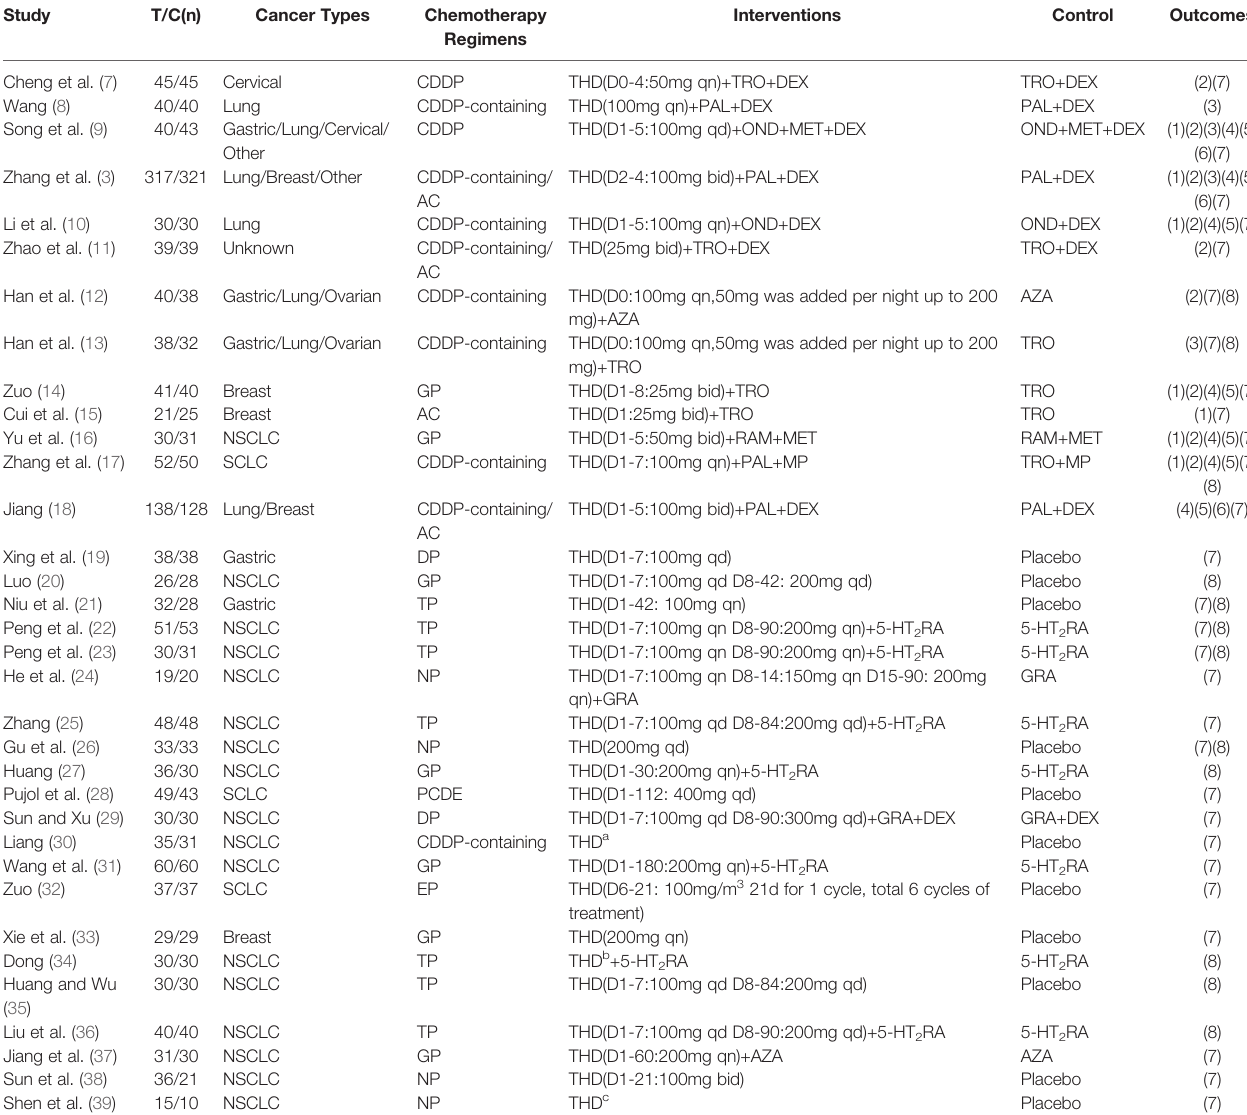
TABLE 1 | Characteristics of studies